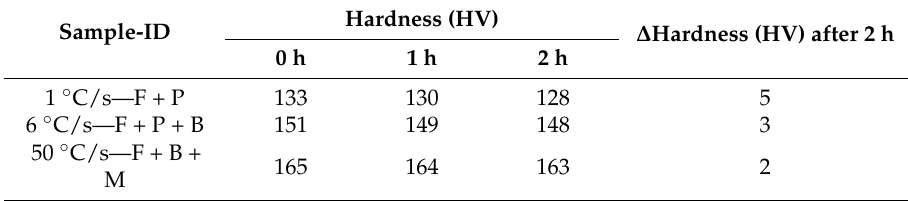
Table 3. Effect of different quenching rate on hardness properties before and after immersion into 3.5 wt. % NaCl solution, as per agreement with ASTM E140.